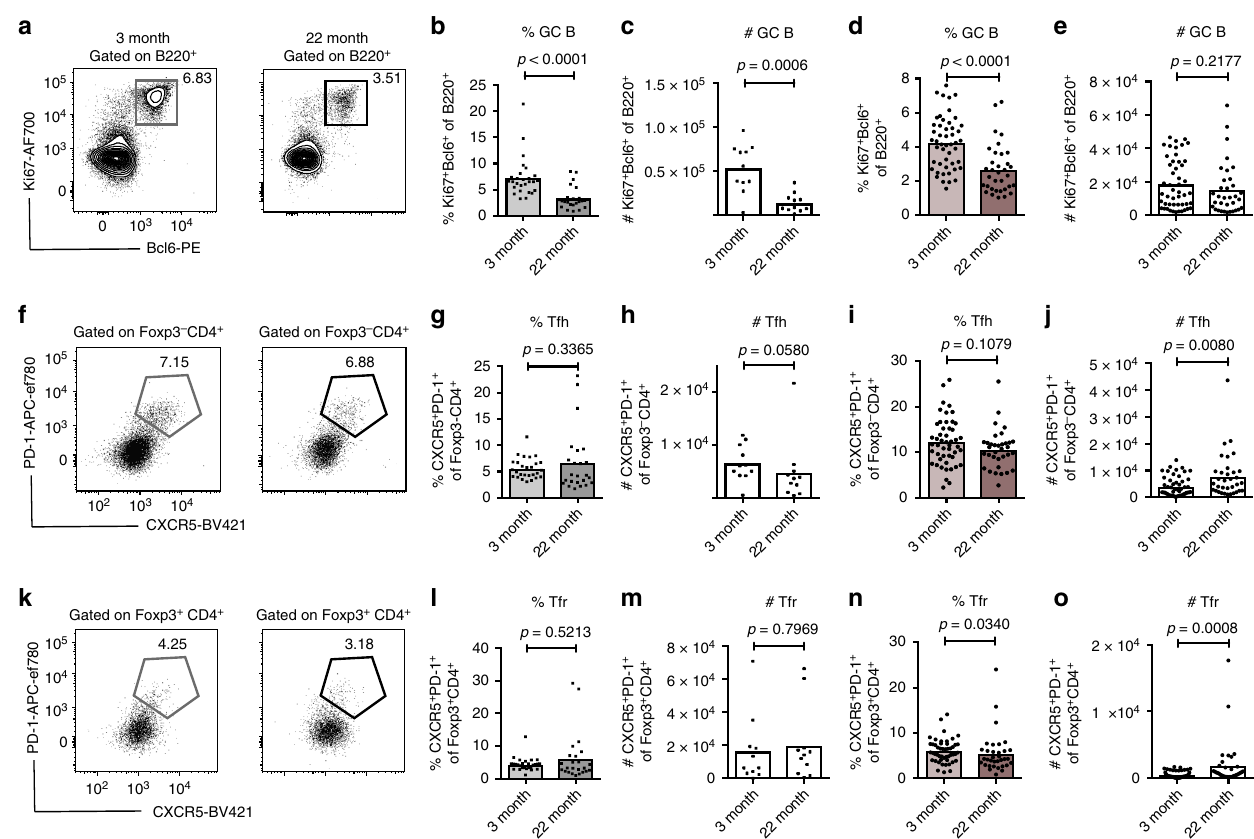
Fig. 1 Germinal centre B cells are reduced in the Peyer ’ s patches of aged BALB/c and C57BL/6 mice. Flow cytometric analysis of germinal centre (GC) cell populations in the Peyer ’ s patches (PPs) of adult (3-month-old) and aged (22-month-old) BALB/c and C57BL/6 mice. a – c Representative fl ow cytometric plots ( a ) and quantitation of B220 + Ki67 + Bcl6 + GC B cells ( b , c ) in the PPs of 3-month-old and 22-month-old BALB/c mice. d , e Quantitation of B220 + Ki67 + Bcl6 + GC B cell percentage ( d ) and number ( e ) in C57BL/6 mice. f – h Representative fl ow plots ( f ) and quantitation of CD4 + Foxp3 − CXCR5 + PD-1 + Tfh cells ( g , h ) in the PPs of BALB/c mice. i , j Quantitation of Tfh cell percentages ( i ) and numbers ( j ) in C57BL/6 mice. k – m Representative fl ow plots ( k ) and quantitation of CD4 + Foxp3 + CXCR5 + PD-1 + Tfr cells ( l , m ) in BALB/c mice. n , o Quantitation of Tfr cell percentages ( n ) and numbers ( o ) in C57BL/6 mice. Bar graphs show the combined results of 3 – 6 independent experiments which were performed with female BALB/c mice and both male and female C57BL/6 mice with a total of n = 11 – 49 mice per group. Bar height corresponds to the mean, and each circle represents one biological replicate. P -values were determined using the Mann-Whitney test in GraphPad Prism6. Source data are provided as a Source Data fi